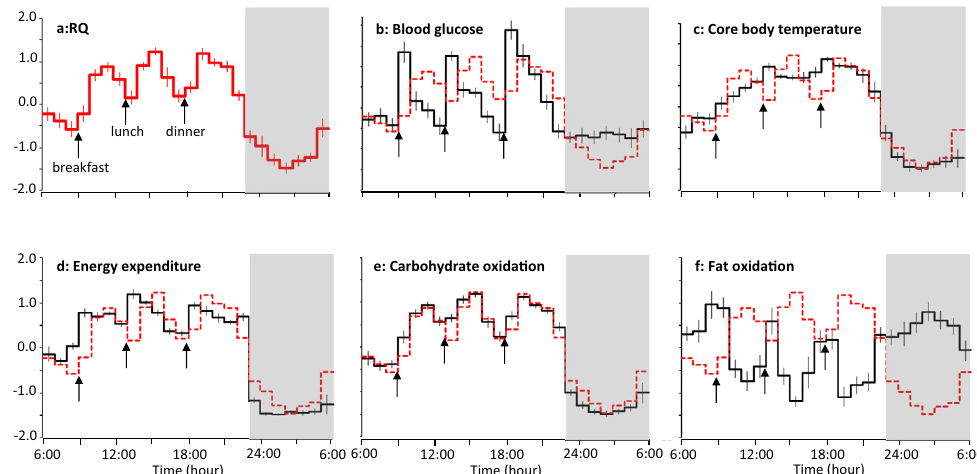
Figure 1. Standardized time course of energy metabolism, body temperature and blood glucose. Hourly average of RQ ( a ), blood glucose ( b ), core body temperature ( c ), energy expenditure ( d ), carbohydrate oxidation ( e ) and fat oxidation ( f ) of each subject were standardized, and mean ± SE of 11 men are shown. For comparison, time course of RQ was shown as red dotted line in panels ( b – f ). Data were derived from a sedentary control trial of a previous experiment focused on the effect of exercise on peripheral clock gene expression (24.5 ± 2.8 years; BMI 22.2 ± 1.9 kg/m 2 ; body fat 16.1 ± 3.8%) 22 . Prescribed diet was provided as breakfast (9:00), lunch (13:00), and dinner (18:00). Subjects slept for 7 h from 23:00 to 6:00 (grey